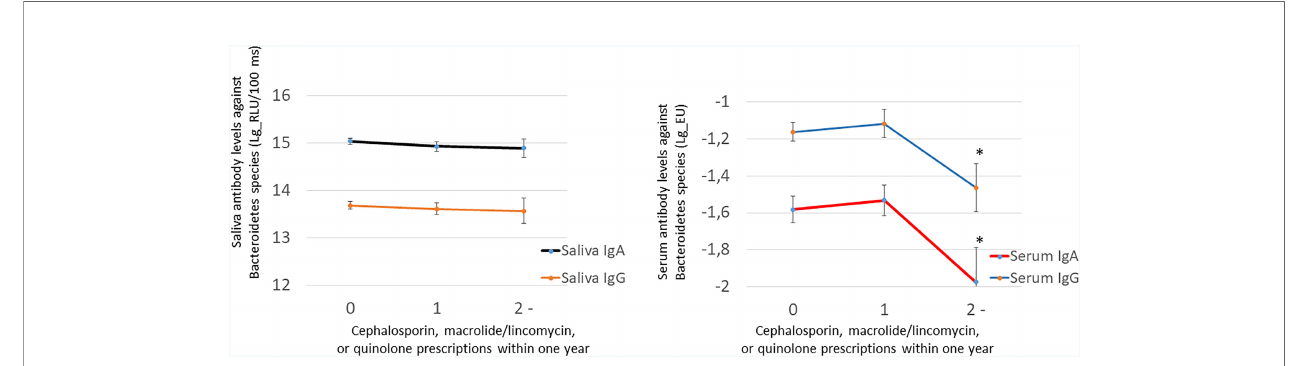
FIGURE 5 | The effect of cephalosporin, macrolide/lincomycin, or quinolone use on saliva and serum antibodies against the Bacteroidetes species. Saliva antibodies were determined using a chemiluminescence immunoassay and serum antibodies using the multiserotype ELISA. Both IgA and IgG class antibodies were measured. The antibody levels against the Bacteroidetes species comprise summed values from separate assays of P. gingivalis , P. endodontalis , P. intermedia , and T. forsythia . The number of patients in the groups are 0, 286; 1, 127; and ≥ 2, 38. The star depicts a p -value <0.05 compared with nonusers of antibiotics as produced by LSD test after